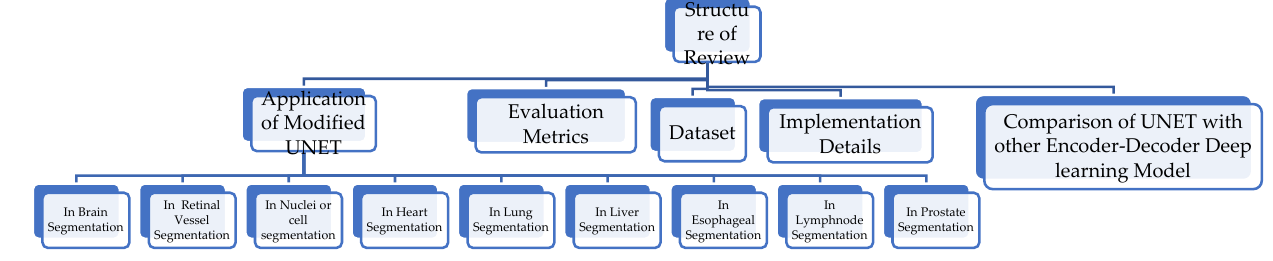
Figure 3. Structure of the review.